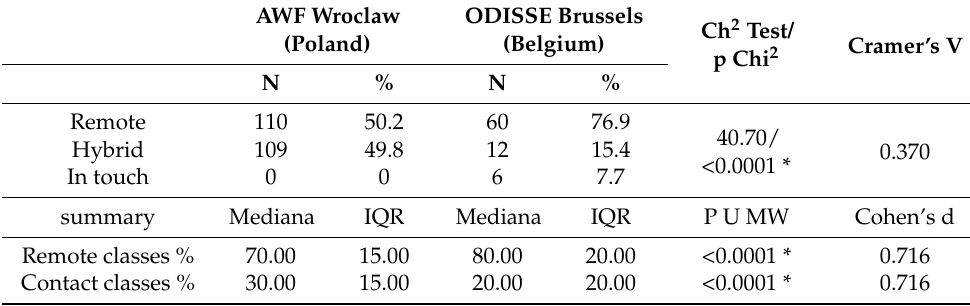
Table 2. Method of carrying out classes in the academic year